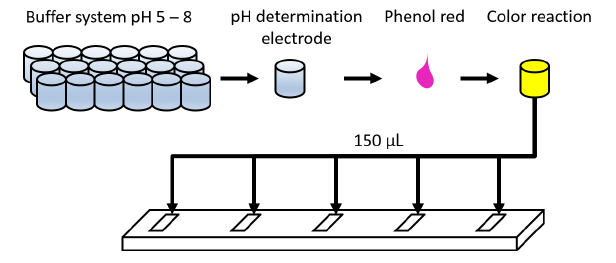
Figure 2. Diagram of the experimental procedure.